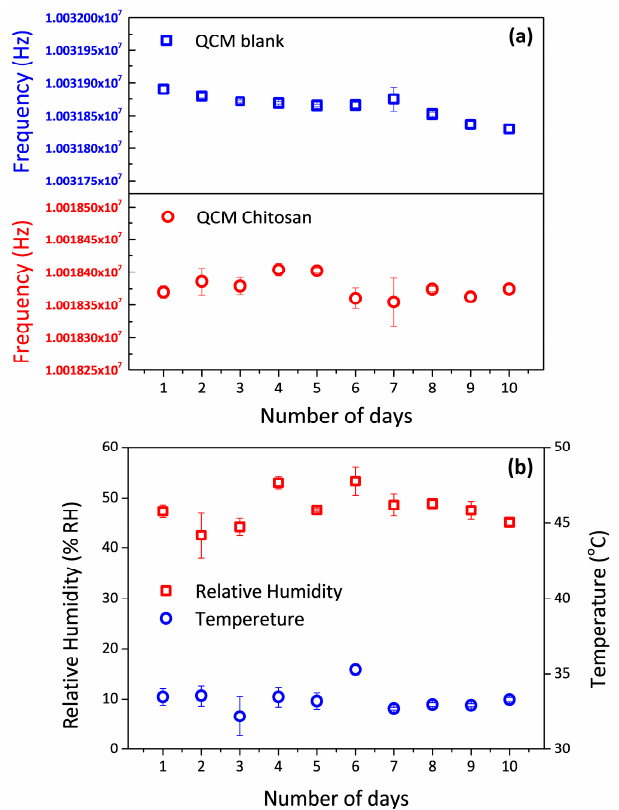
Figure 7. ( a ) Long-term resonant frequency shift of blank QCM and chitosan-based QCM sensing system for the first 10 days of measurement, and ( b ) change in RH and temperature for the first 10 days of measurement.